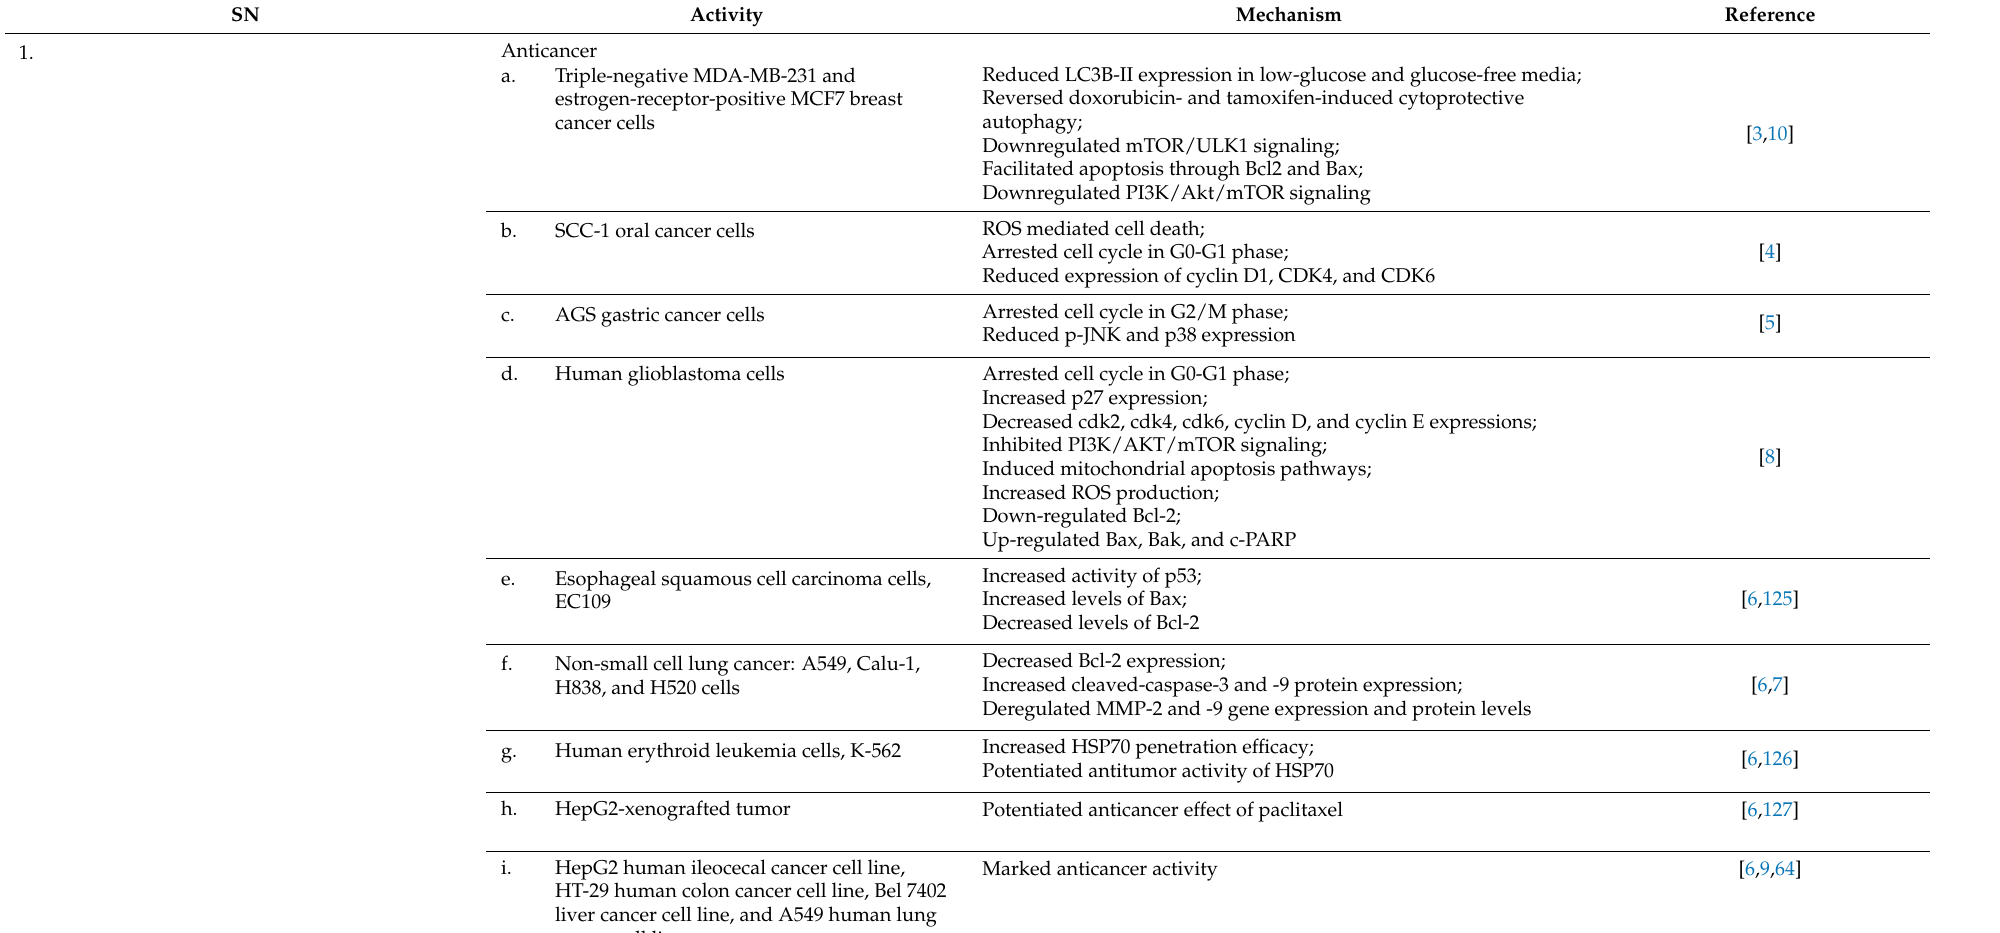
Table 3. Therapeutic potential and molecular mechanisms of